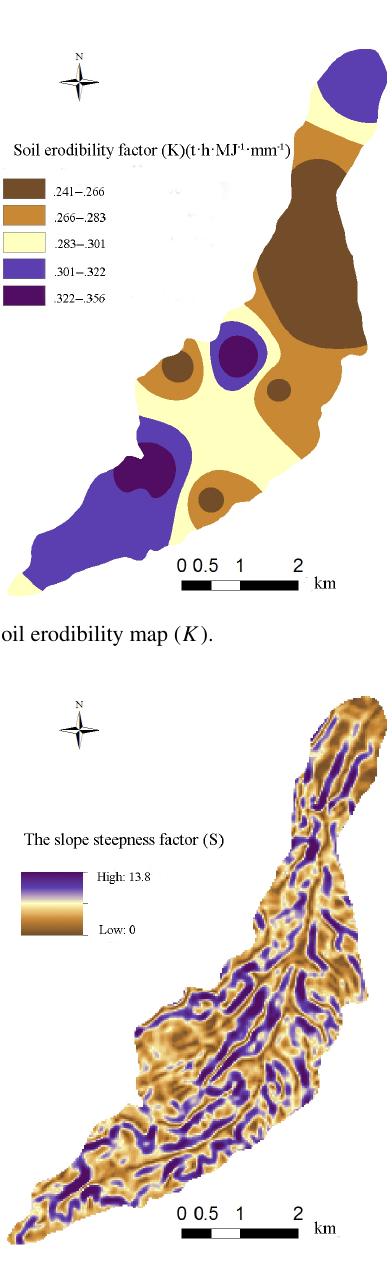
Figure 6. Spatial distribution of the slope steepness